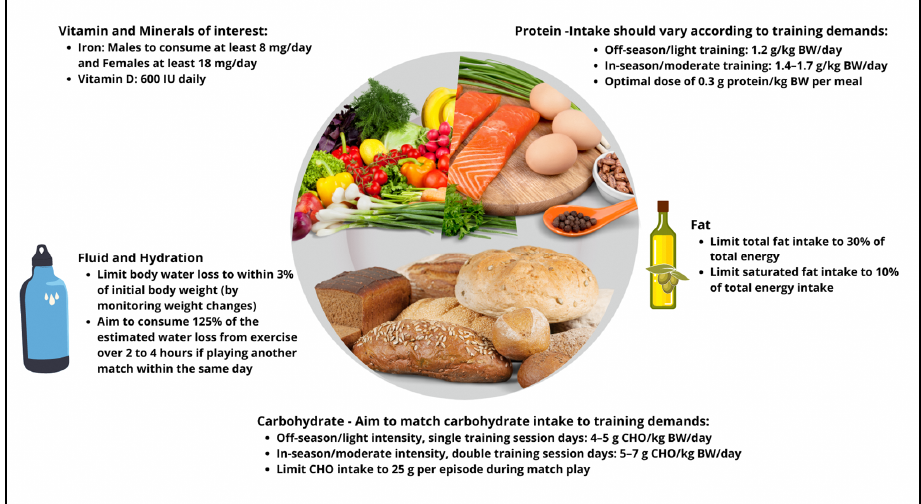
Figure 3. Summary of nutritional recommendations (macronutrients, key micro-nutrients of interest and hydration) for table tennis players based on the physiological demands of table tennis game play and